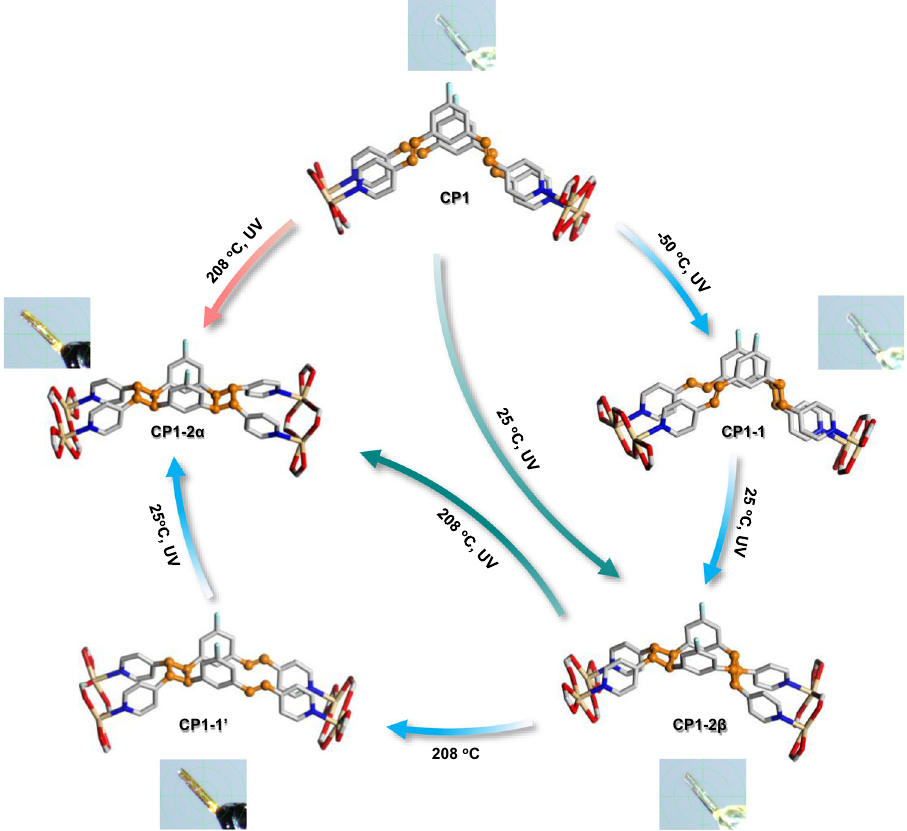
Fig. 2 Synthesis routes and structures of the multiple-step thermal/photo-induced transformations of CP1 to CP1-2 α . The con fi gurations of CP1 - 1 , CP1 - 2 β , CP1 - 1 ′ , and CP1 - 2 α illustrate the monomer transformations for each step. Inset: crystal photographs of CP1 in the multiple-step thermal/photo- induced transformations. Color codes: Cd, pale yellow; N, blue; F, sky blue; O, red; C, gray. Hydrogen atoms are omitted for clarity. All the con fi gurations and transformations of C = C groups associated with the above reactions are highlighted in